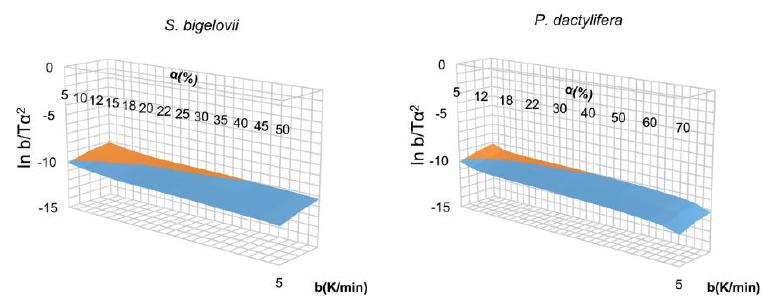
Figure 4. FWO Plot for S. bigelovii , P. dactylifera.